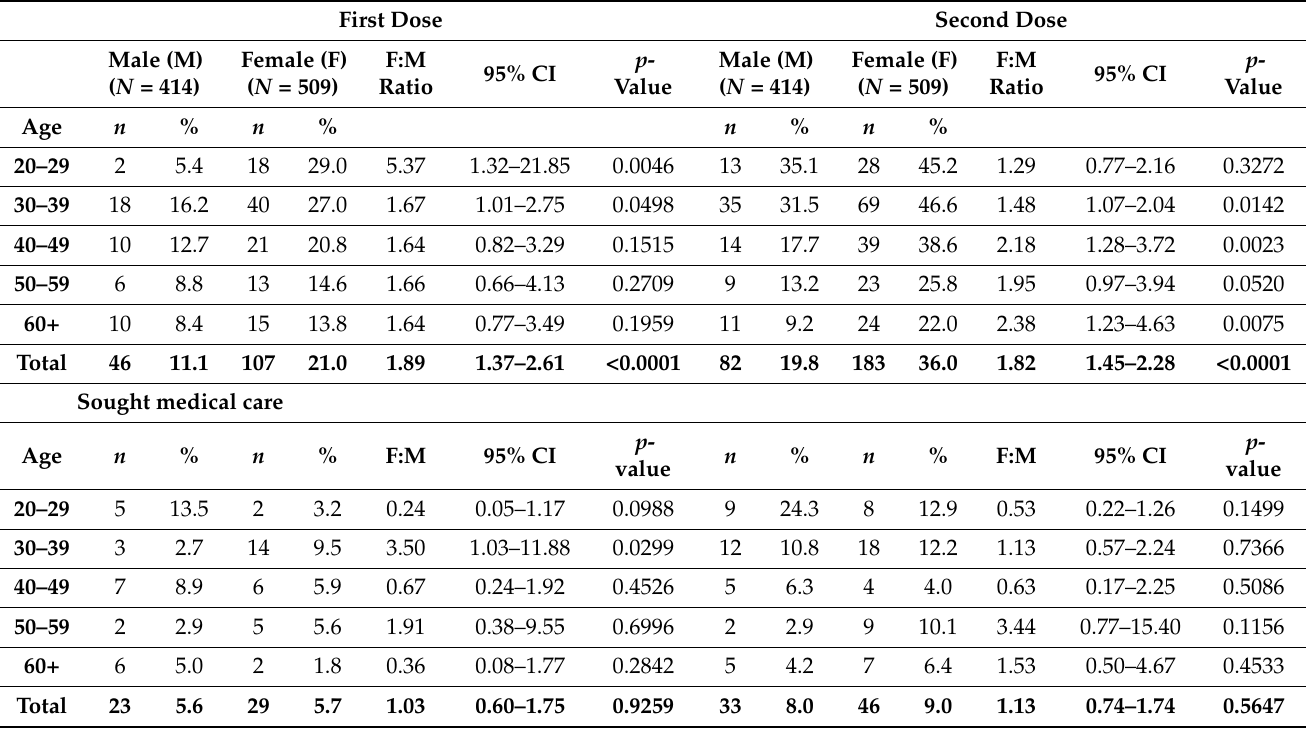
Table 1. Female-to-male ratio of the percentage reporting adverse events following each of two doses of the Pfizer-BioNTech COVID-19 vaccine and whether or not they sought medical care, in an online panel survey in Israel, by age